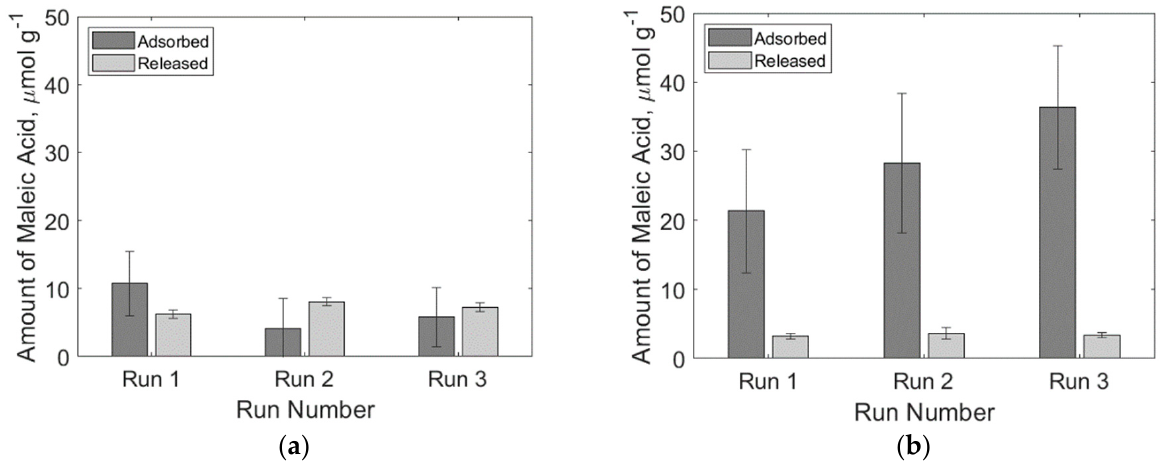
Figure 9. Potential-controlled adsorption and release experiments for 5 mM maleic acid at pH 7 onto untreated ( a ) and oxidized ( b ) CNT-K monoliths. A potential of +500 mV for the adsorption and − 500 mV for the desorption phase was applied for all experiments. Potentials were applied for 15 min during adsorption and release phase.